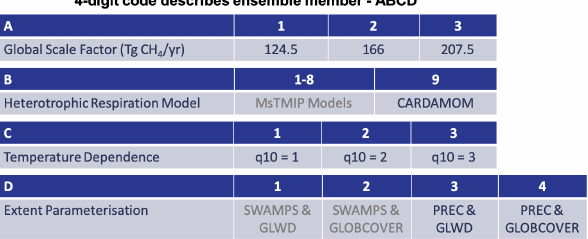
Figure 1. Description of the four-digit code used throughout this work to identify the configuration of the WetCHARTs ensemble members. For the extended WetCHARTs period of 2009–2018, there is only one heterotrophic-respiration model (CARDAMOM) and two wetland extent parametrisations (using ERA-Interim pre- cipitation) available, giving a total of 18 different